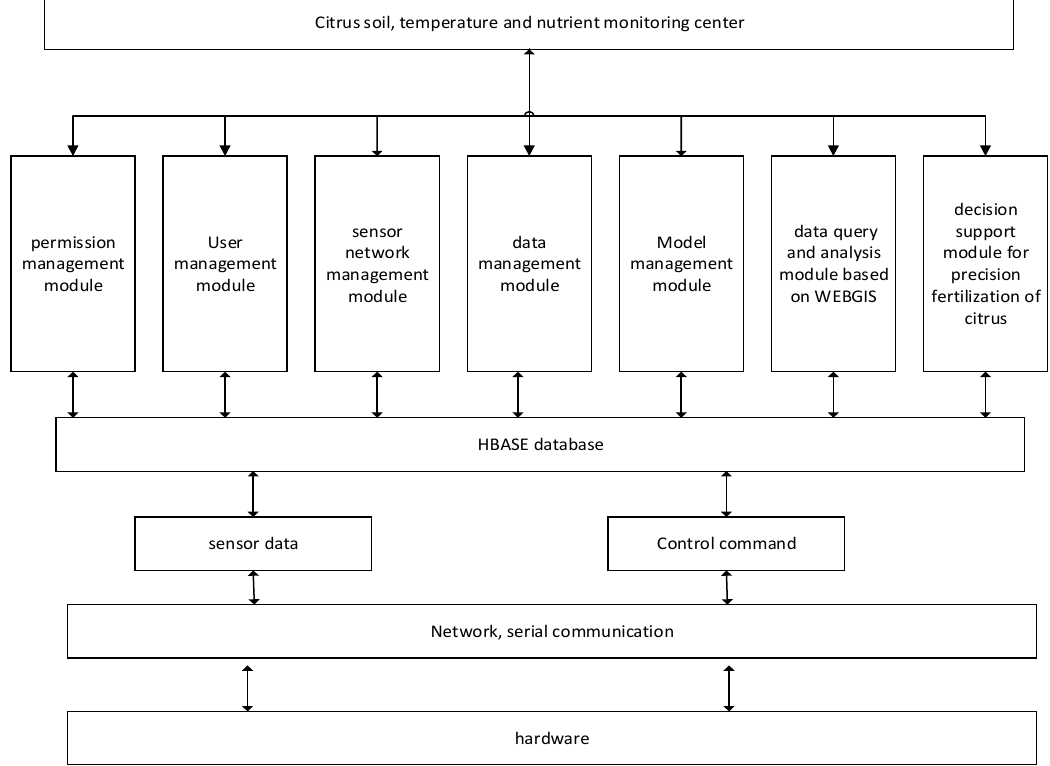
Figure 5. Software architecture of citrus soil temperature and humidity monitoring system.